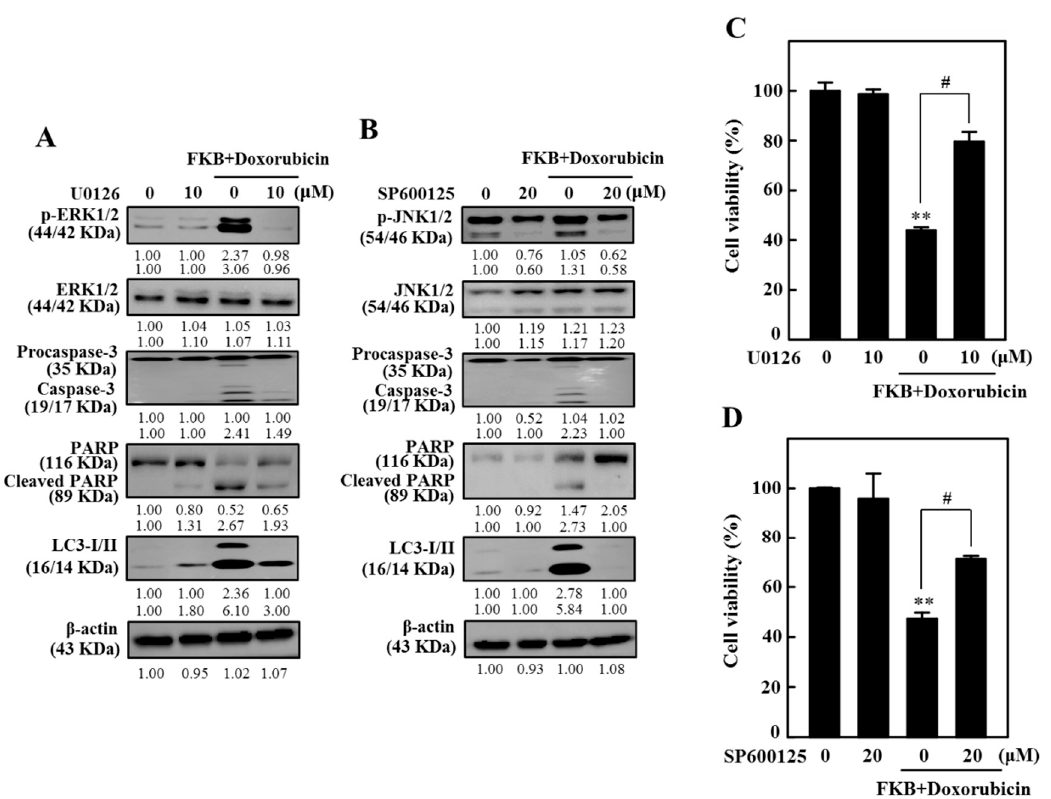
Figure 8. FKB + doxorubicin mediated apoptotic-and autophagic-cell death by upregulating pathways of ERK and JNK in AGS cells. Cells were pretreated for 30 min with U0126 (10 µ M) or SP00125 (20 µ M), followed by co-treatment with FKB (2.5 µ g / mL) and doxorubicin (0.5 µ g / mL) for 24 h. ( A , B ) The e ff ect of FKB and doxorubicin co-treatment on expression of LC3-I / II, caspase-3, and PARP was investigated and then changes in total and phosphorylated levels of ERK and JNK were assessed by Western blot, with caspase-3 and PARP expressions (Figure S7A,B). ( C , D ) The MTT assay was used to assess the cell viability. Values were set to mean ± SD ( n = 3). Compared with untreated control cells, significant at ** p < 0.01. Significant in # p < 0.05 compared to cells treated with FKB +